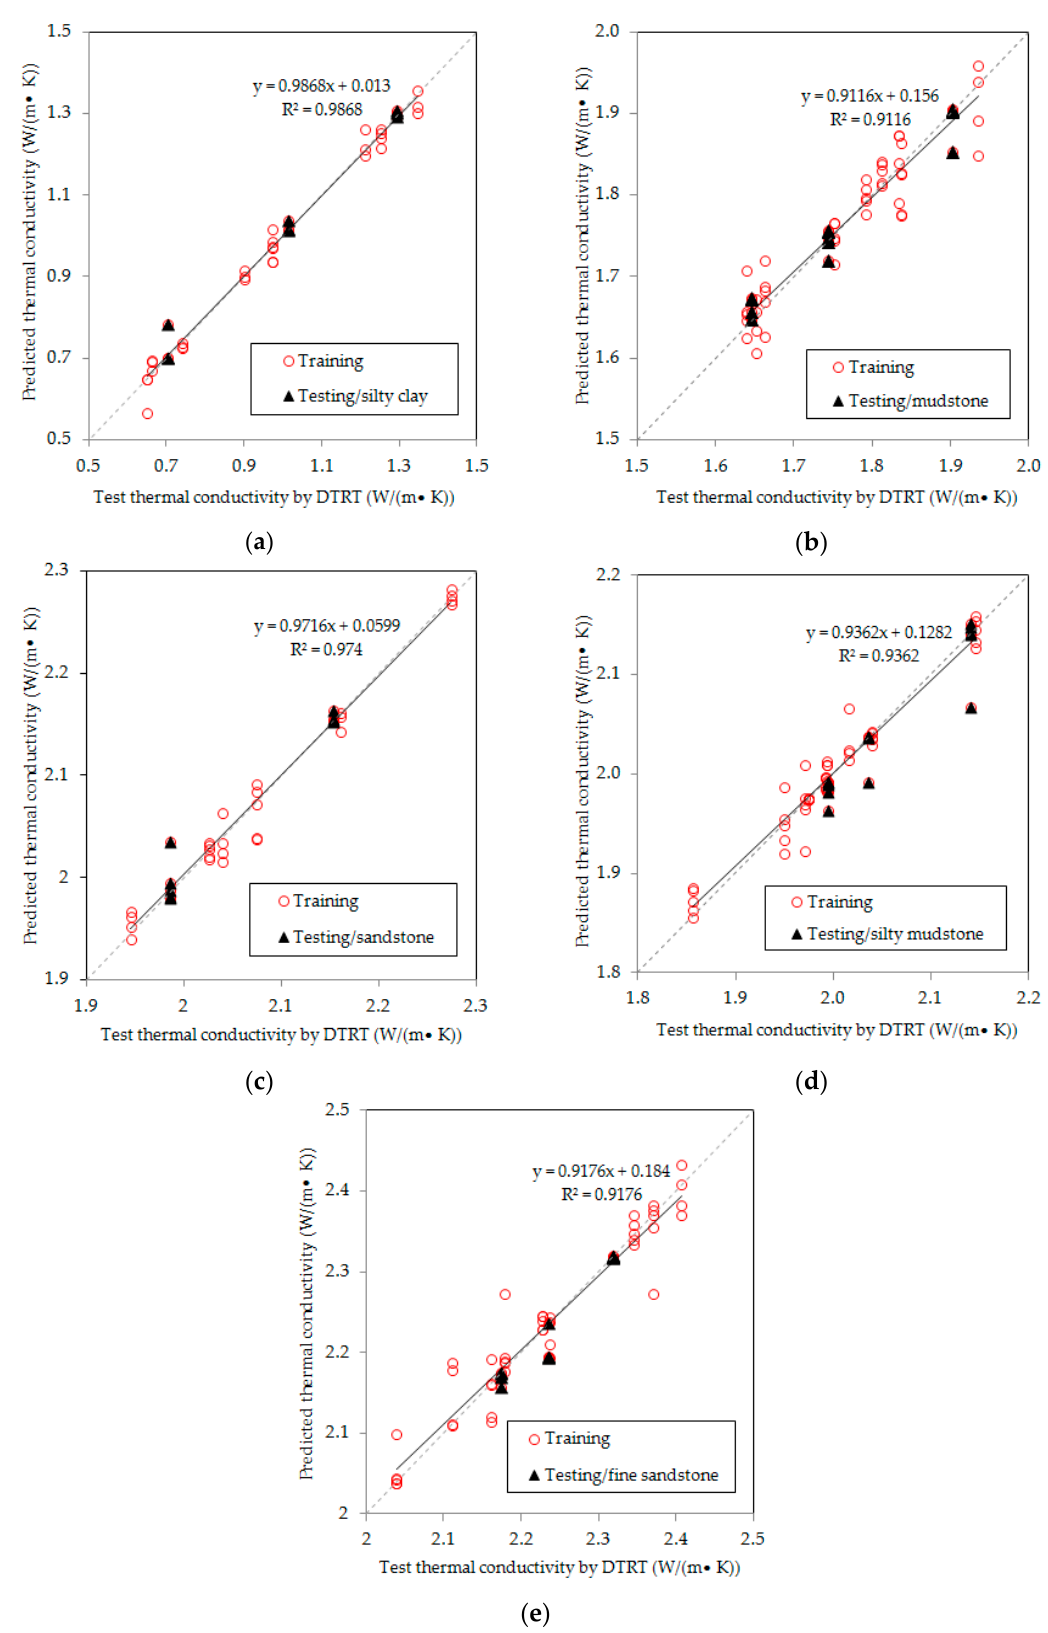
Figure 11. Correlation of experimental and predicted layered thermal conductivity, ( a ) silty clay, ( b ) mudstone, ( c ) sandstone, ( d ) silty mudstone, ( e ) fine sandstone. R 2 —coefficient of determination.